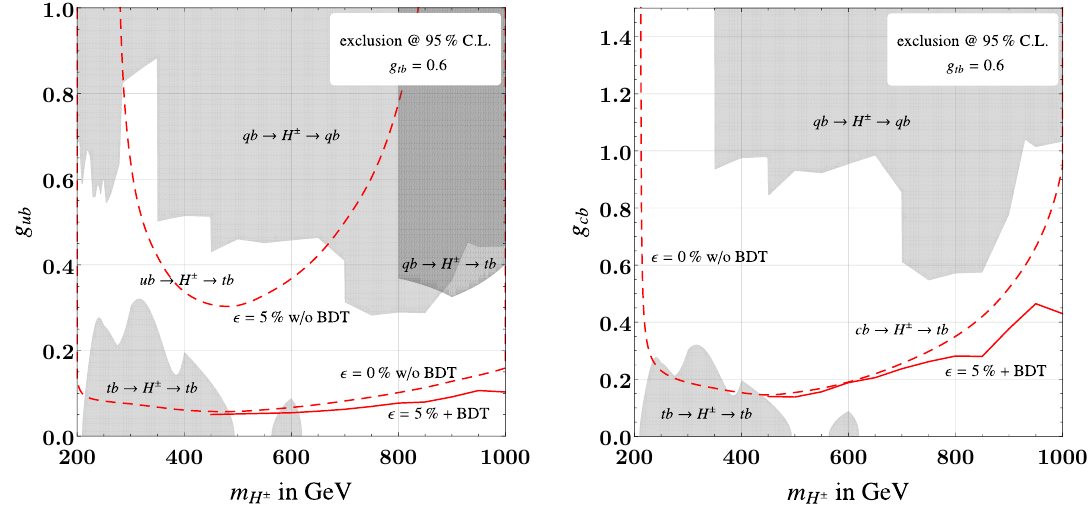
Figure 18 . Expected 95% CL exclusion limits in the plane m /g ub (left panel) and m /g cb H ± H ± (right panel) for fixed g = 0 . 6 . Shown in gray are the constraints from single coupling searches tb based on dijet searches [62] denoted by “ qb → H ± → qb ”, searches for top-associated charged Higgs production and decay [57] denoted by “ tb → H ± → tb ”, and the constraints from resonant charged Higgs production decaying into tb [58] denoted as “ qb → H ± → tb ”. The latter are relevant only for g ub and large Higgs masses. The red lines indicate the parameter space that could be probed by the search described in section 3.4, denoting the constraints from applying the cuts in figure 16 with (solid) or without BDT optimization (dashed), for different assumed systematic errors (cid:15)